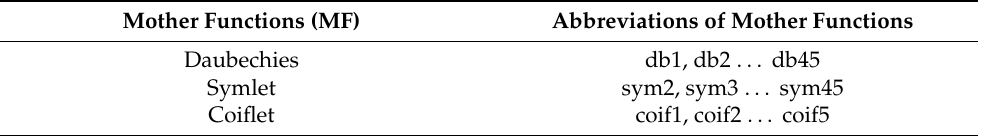
Table 4. All MF used in this